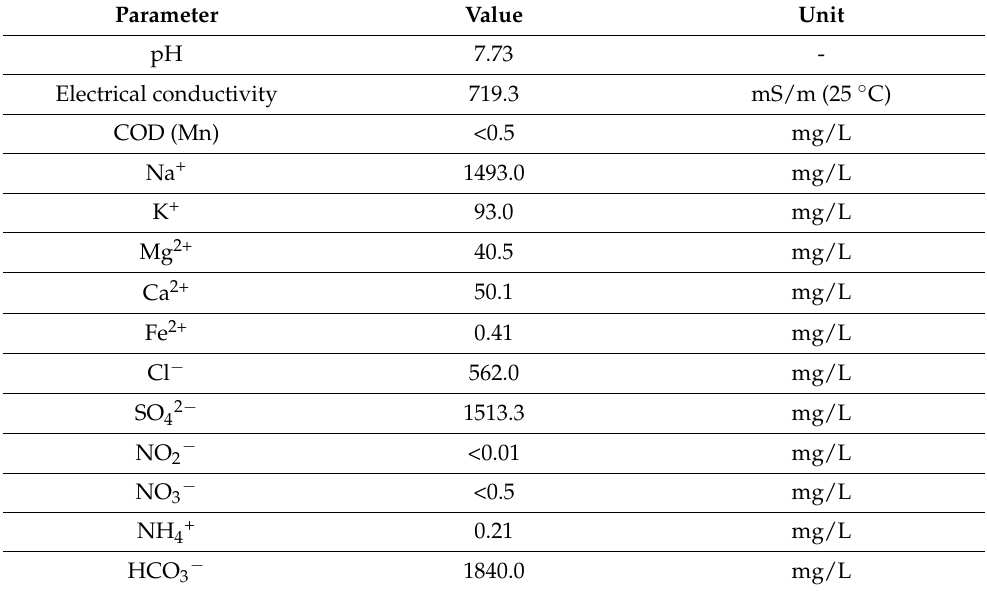
Table 3. Chemical composition of the thermomineral water in the studied balneological facility. Parameter Value Unit pH